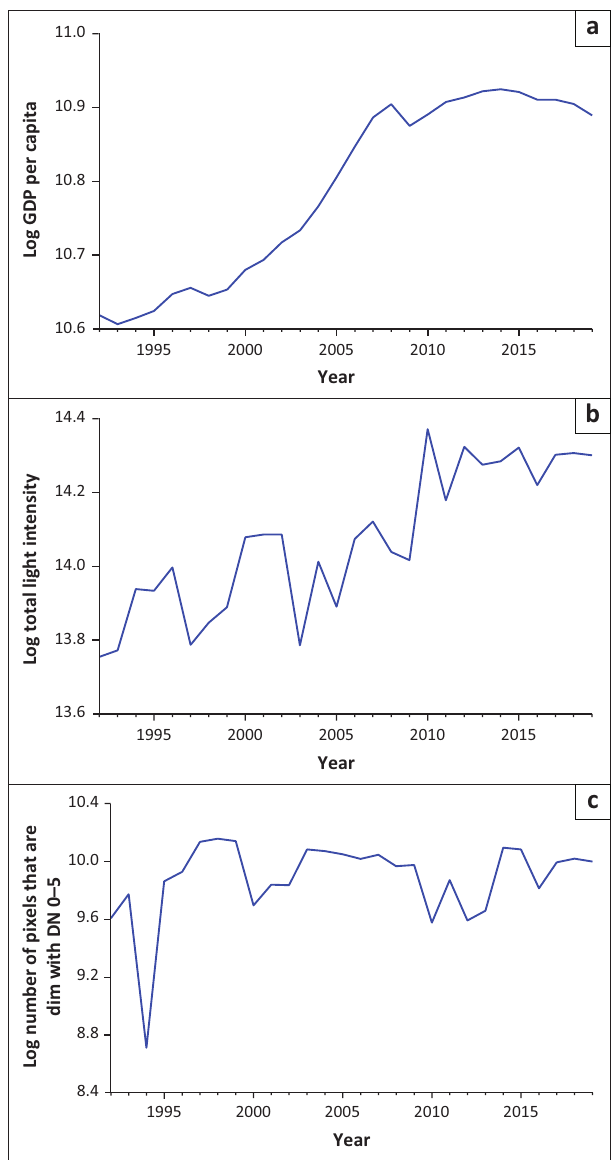
FIGURE 7: Gross domestic product per capita and total light intensity, 1992–2019. (a), LNGDPCAPITA; (b), LNSUMLIGHT and (c), LNBCOUNT.